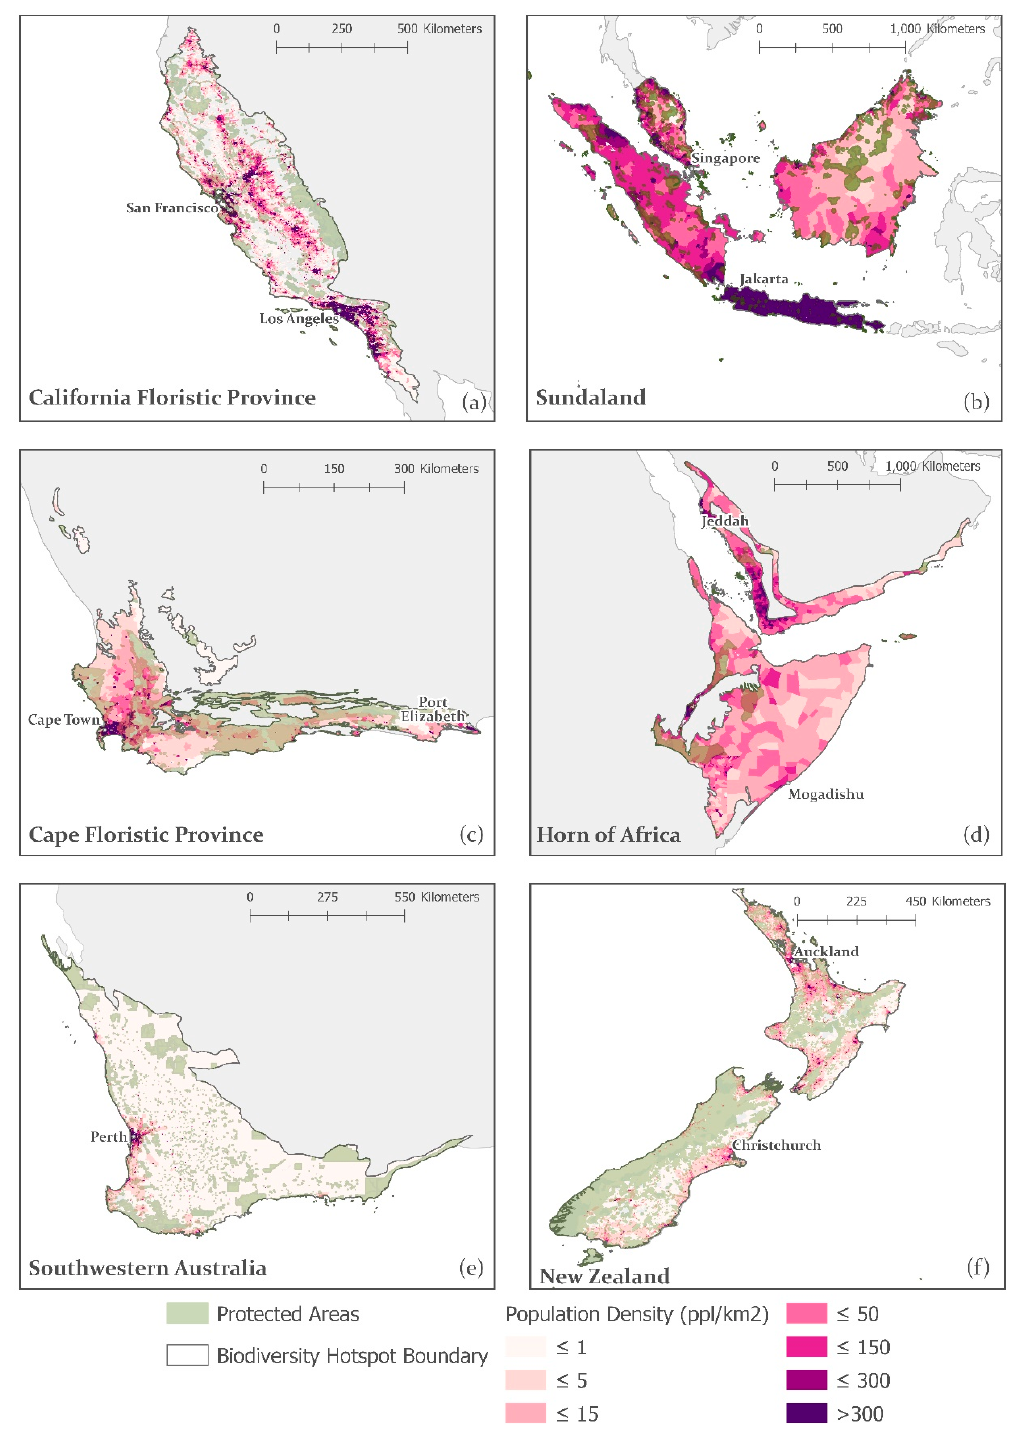
Figure 5. Patterns of protected area and population density in biodiversity hotspots: ( a ) California Floristic Province (15.3% protected area in 2015), ( b ) Sundaland (13.6% protected area in 2015), ( c ) Cape Floristic Province (47.4% protected area in 2015), ( d ) Horn of Africa (8.8% protected area in 2015), ( e ) Southwestern Australia (17.1% protected area in 2015), and ( f ) New Zealand (32.6% protected area in 2015).